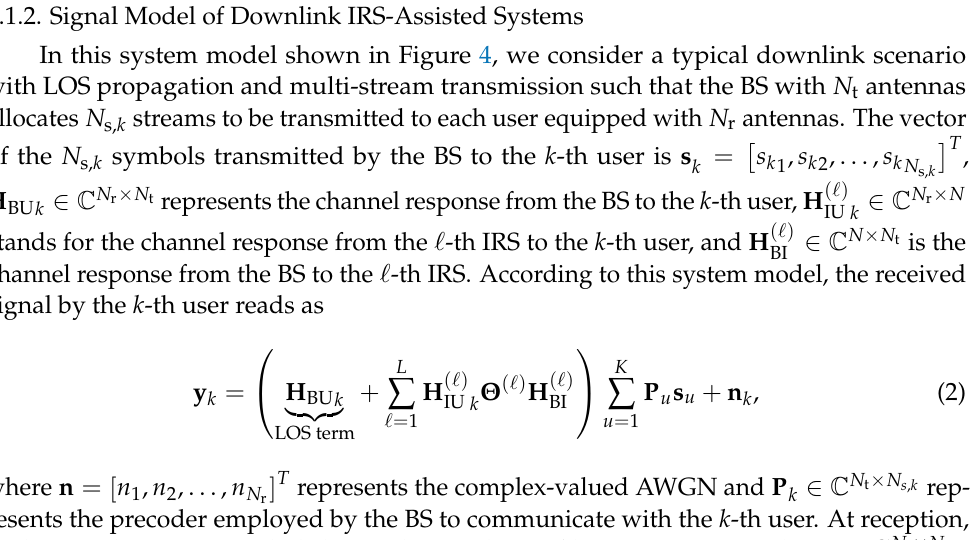
Figure 3. Uplink multiuser and multi-IRS-aided system in LOS conditions.